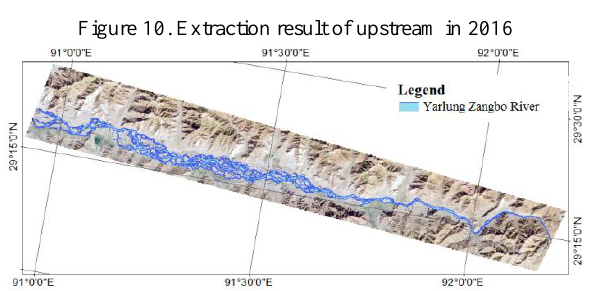
Figure 10. Extraction result of upstream in 2016